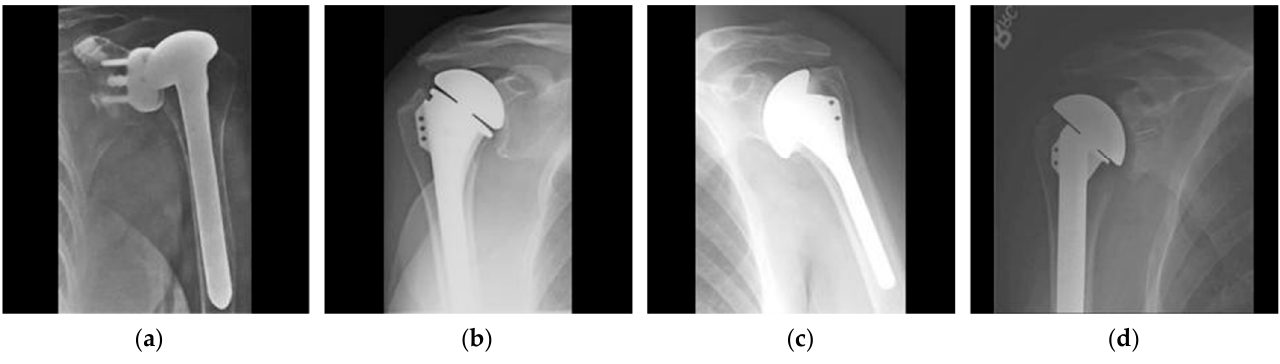
Figure 1. Example images of the four manufacturers: ( a ) Cofield, ( b ) Depuy, ( c ) Tornier, and ( d ) Zimmer.